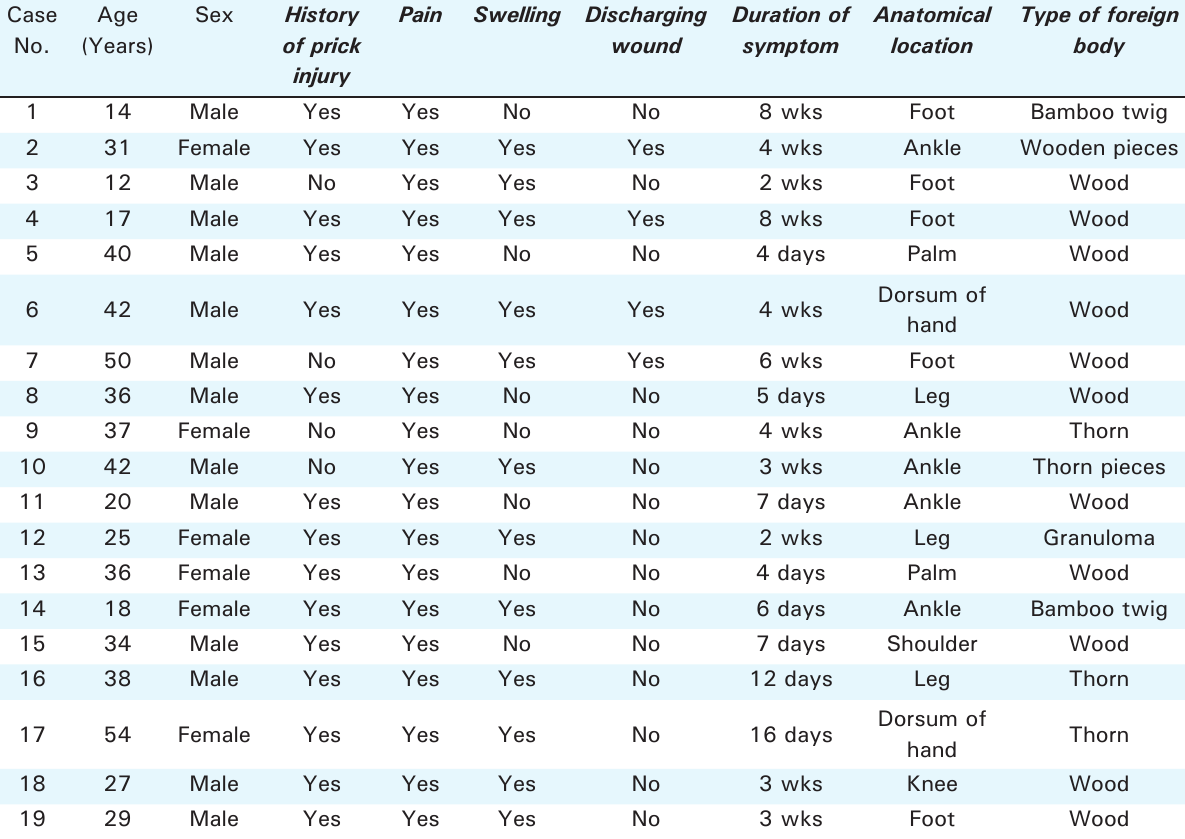
table 1. Age and sex distribution, history, anatomical sites and types of foreign body among 19 patients Case